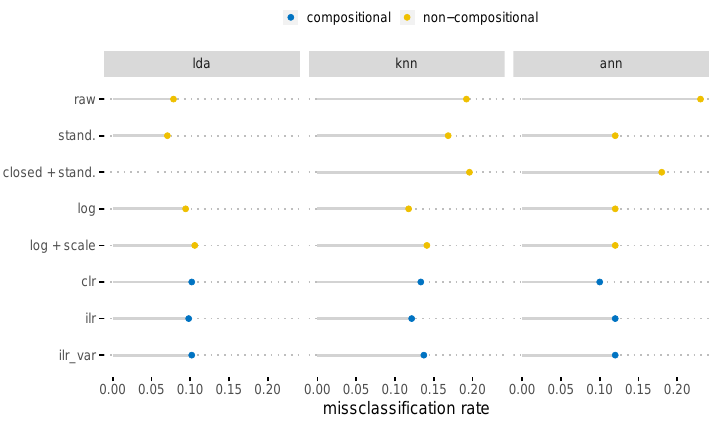
Figure 6. Misclassification rates based on different pre-processing of the saffron